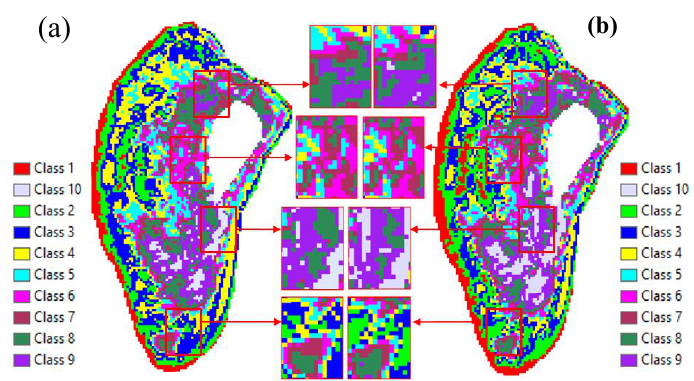
Figure 3. Results of Unsupervised Classification of IsoData and K-Means Methods in Sentinel-2 images with the application of the Lyzenga Algorithm (a) the classification results of the IsoData Method, (b) the results of the K-Means method classification Unsupervised classification IsoData method results shows Means method results shows 13 classes after reclassification that there are 12 classes of shallow water objects and K- process.